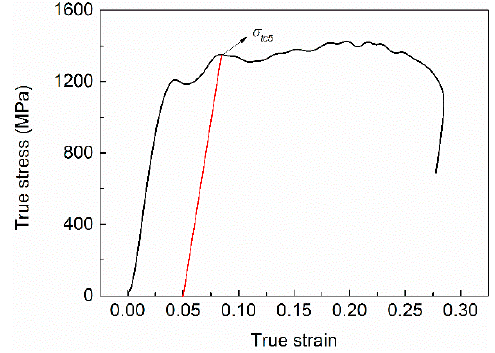
Figure 7. Selection of yield point.